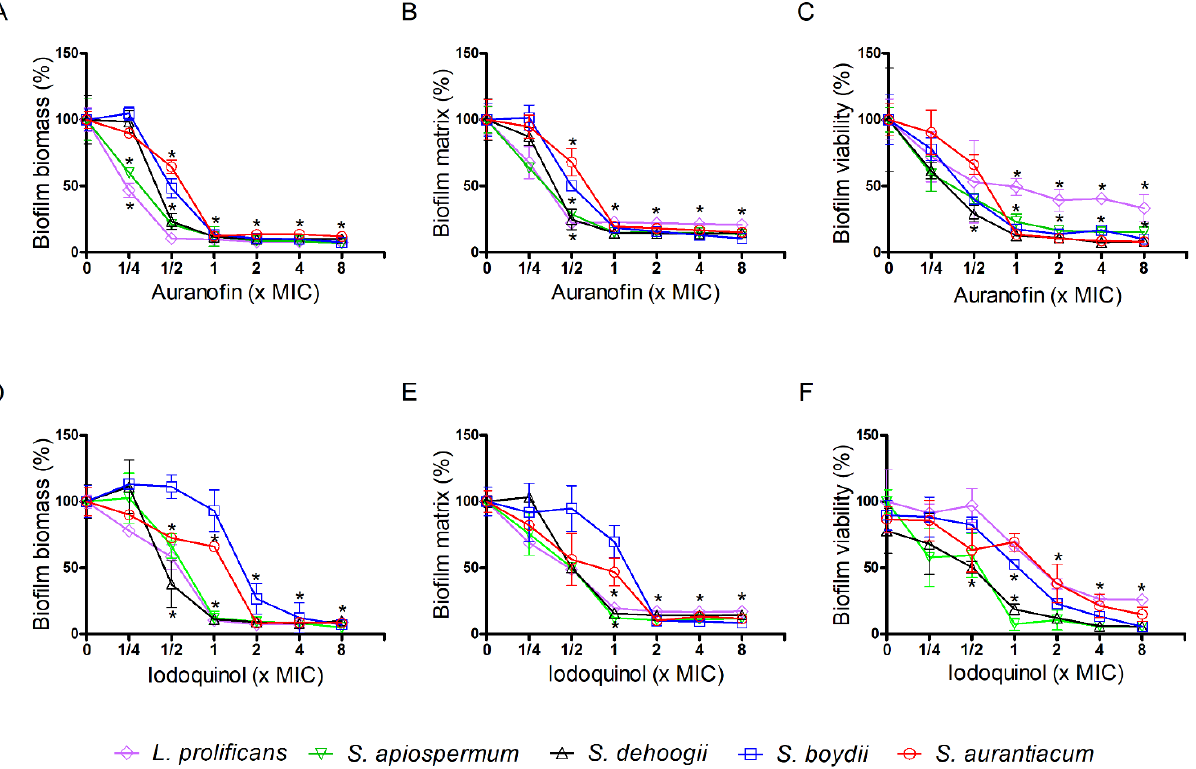
Figure 4. Effect of auranofin ( A – C ) and iodoquinol ( D – F ) on biofilm formation of Scedosporium and Lomentospora species. Fungal cells were adhered on polystyrene surface for 1.5 h and then different concentrations of auranofin or iodoquinol were added. Fungal biomass ( A , D ), extracellular matrix ( B , E ) and viability ( C , F ) were measured using violet crystal, safranin and XTT-reduction assay, respectively. * p < 0.01, compared to 0 (absence of drug) for each species.